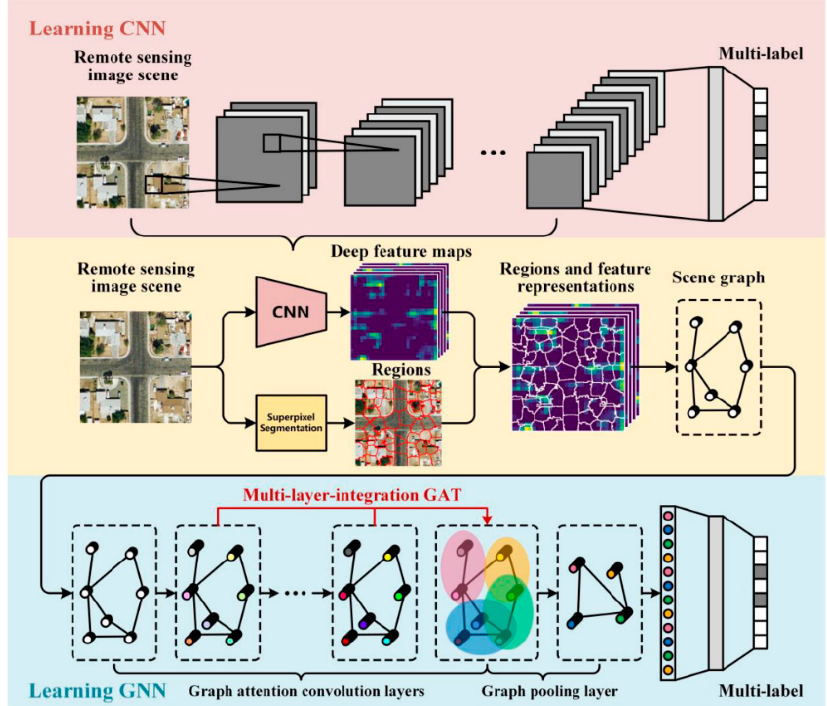
Figure 6. An example of adding an attention network to a GNN module for multi-label RS image classification [82]. classification